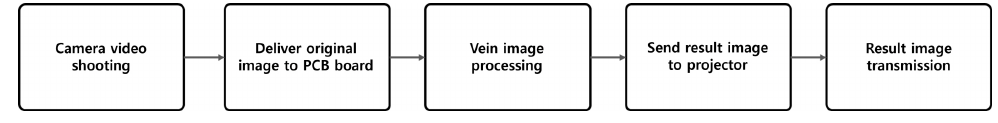
Figure 6. Proposed vein image processing system